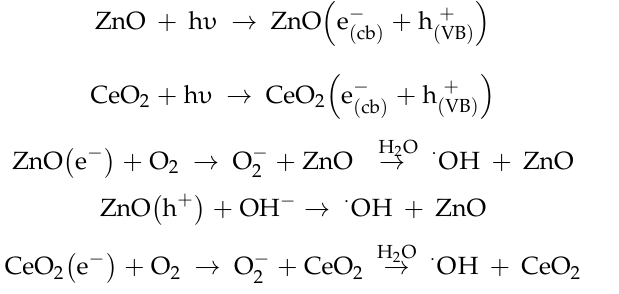
Figure 6. Photocatalytic degradation of ceftriaxone ( a ) and time evolution of the UV-Vis absorption spectrum of ceftriaxone.